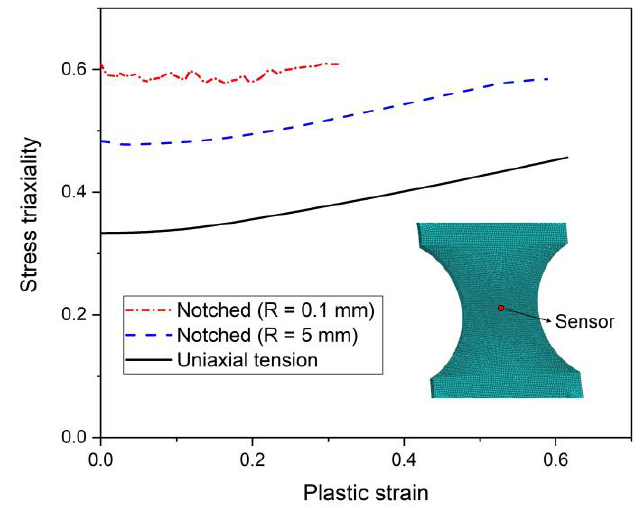
Figure 12. The evolution of stress triaxiality η with the plastic strain at the location showing in the inset.